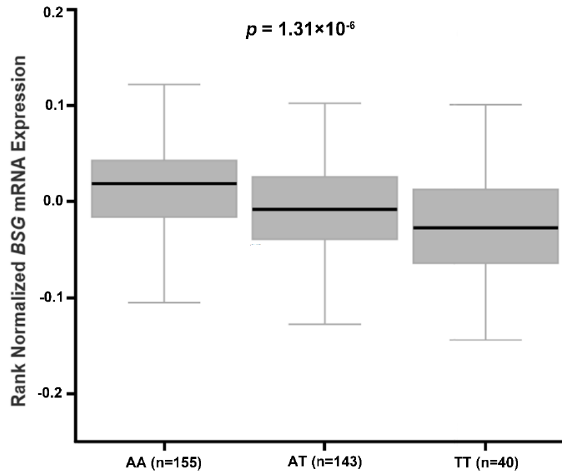
Figure 1. Effect of BSG rs8259 polymorphism on BSG mRNA expression in whole blood from healthy normal donors.